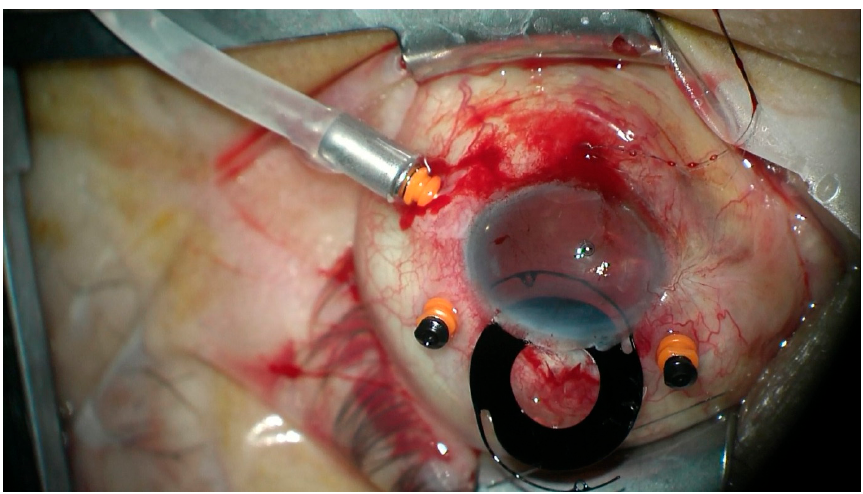
Figure 5. Tying the sutures to the eyelets of the black diaphragm intraocular lens.